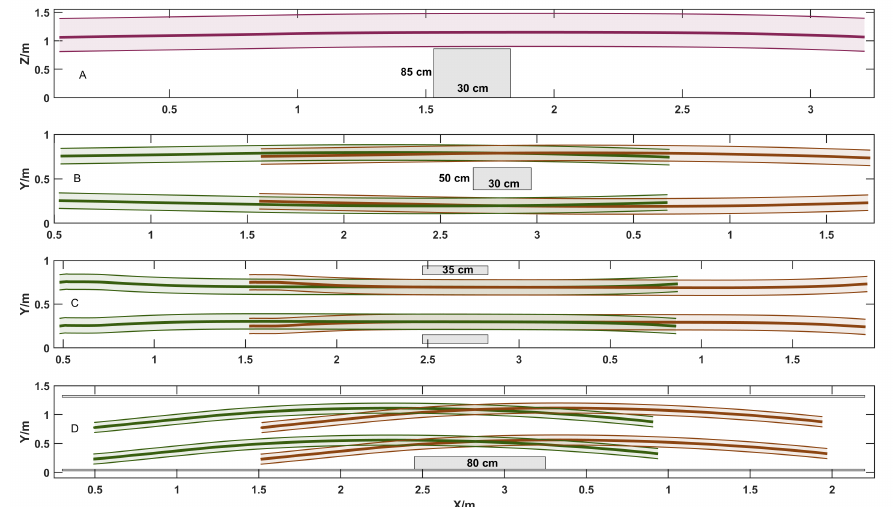
Figure 10. Experiment results from four deformable planning and collision avoidance tasks in confined space.